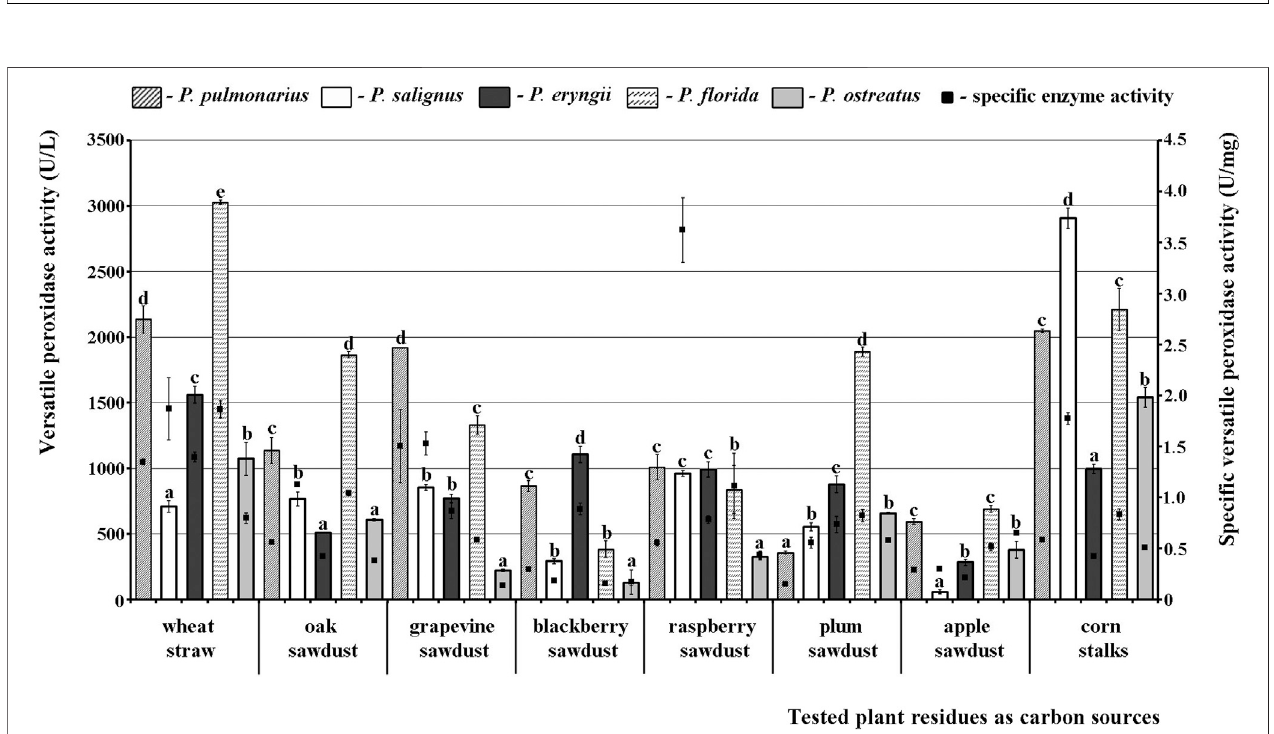
FIGURE 2 | Activity of versatile peroxidases of Pleurotus spp. depending on the type of agro-forestry residues. Values superscripted with the same letter in each values group (for each plant residue) are not signi fi cantly different ( p < 0.05).